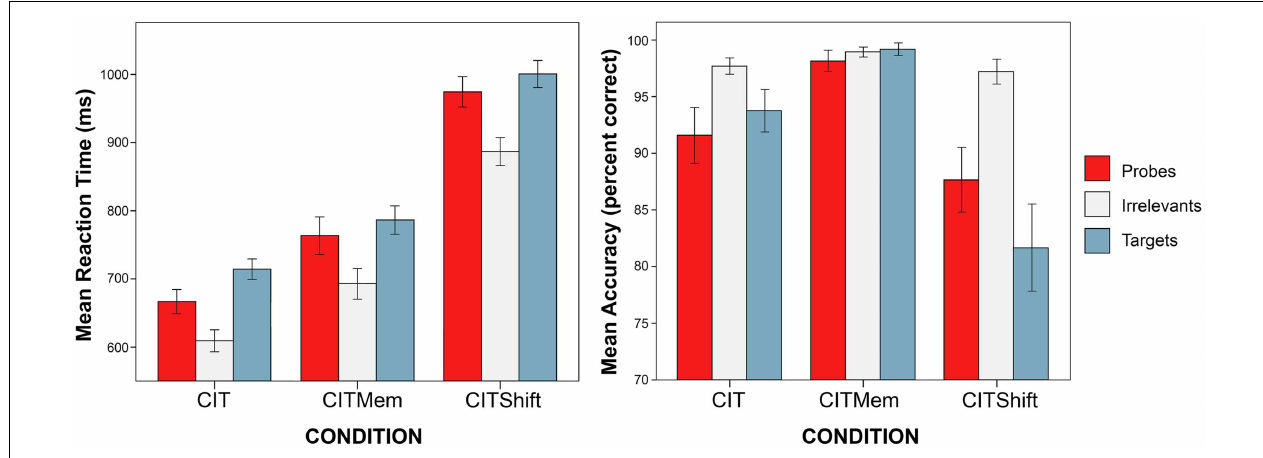
FIGURE 1 | Mean response time ( left ) and accuracy ( right ), according to stimulus type (Probe, Irrelevant, orTarget) and condition (CIT, CITMem, CITShift). Error bars indicate standard error of the mean ( ± 2